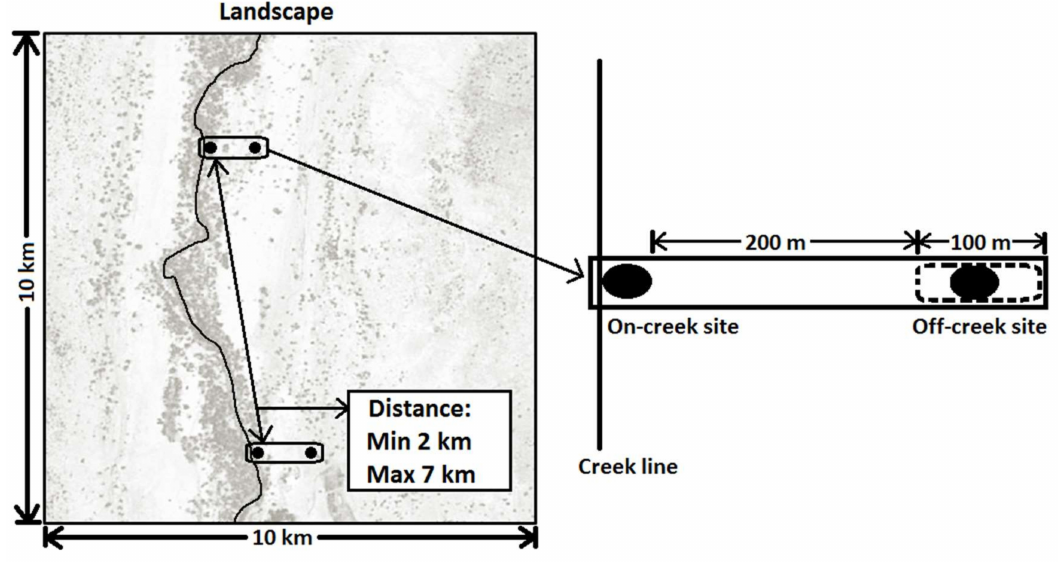
Figure 3. Survey design of the study showing the position of two on-creek sites (black dots) and two off-creek sites (black dots) in a landscape. Corresponding off-creek sites were located between 200 m and 300 m from on-creek